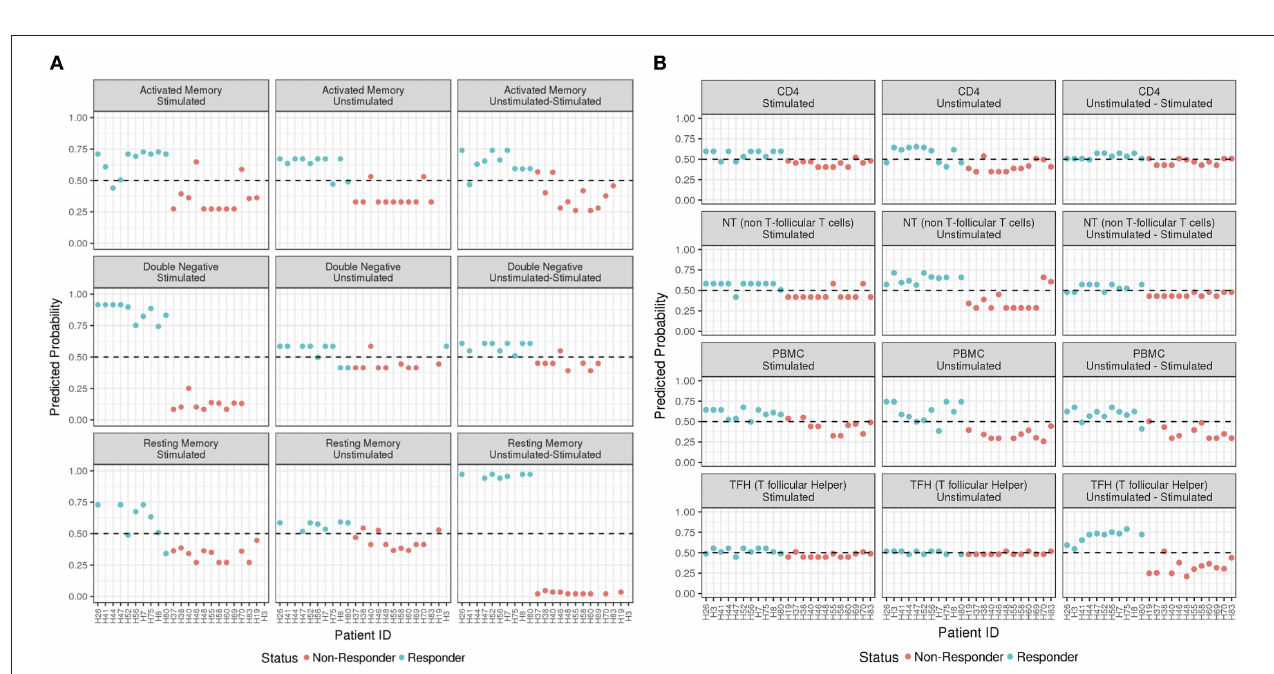
FIGURE 3 | ADA Boost Probability Scores for T Cells (A) and B cell subsets (B) . The probabilities of prediction are shown for each patient (the non-responder in red and responder in blue). If the probability is > 0.50 the patient has been classified as responder, on the contrary if < 0.50.